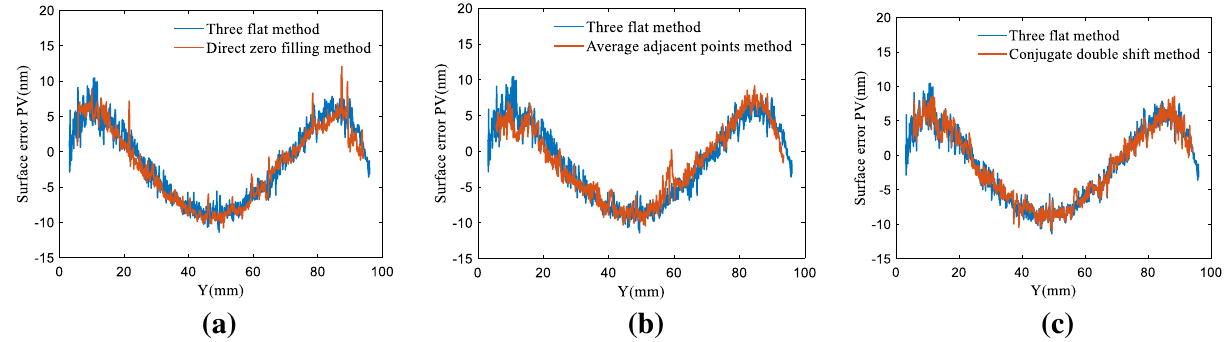
Figure 7. Cross-sectional line comparisons for the conjugate shift differential and three-sided mutual testing methods using different frequency spectrum compensation techniques, including: ( a ) direct zero filling, ( b ) average adjacent points, and ( c ) conjugate double shift.